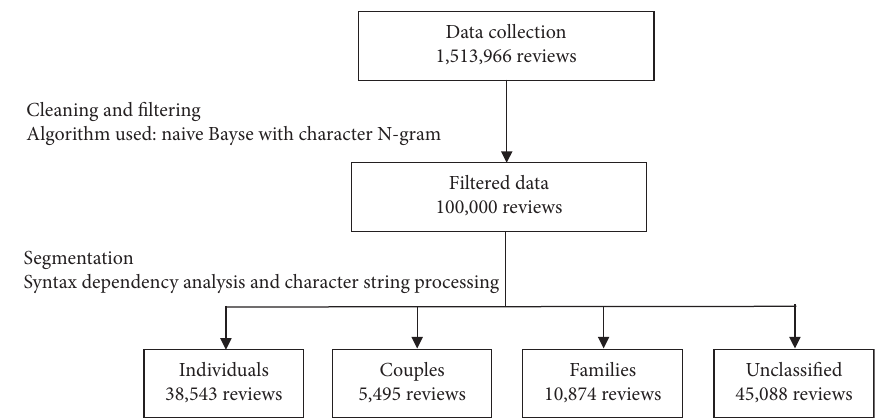
Figure 2: Process cleaning, filtering, and segmentation of data collected from Inside Airbnb.